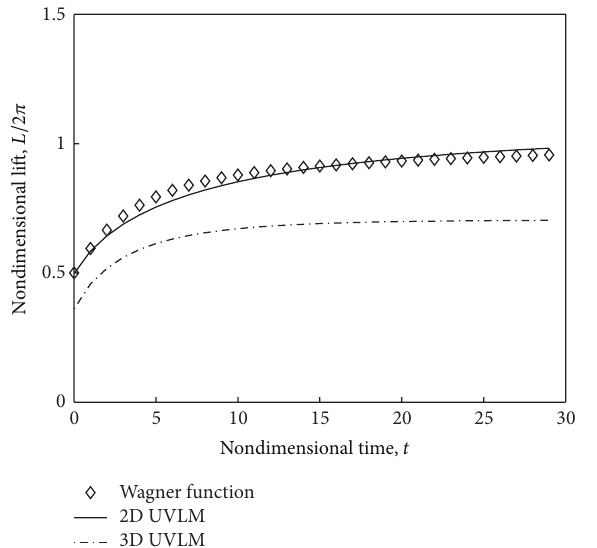
Figure 1: Lift acting on the airfoil due to step change in airfoil downwash.